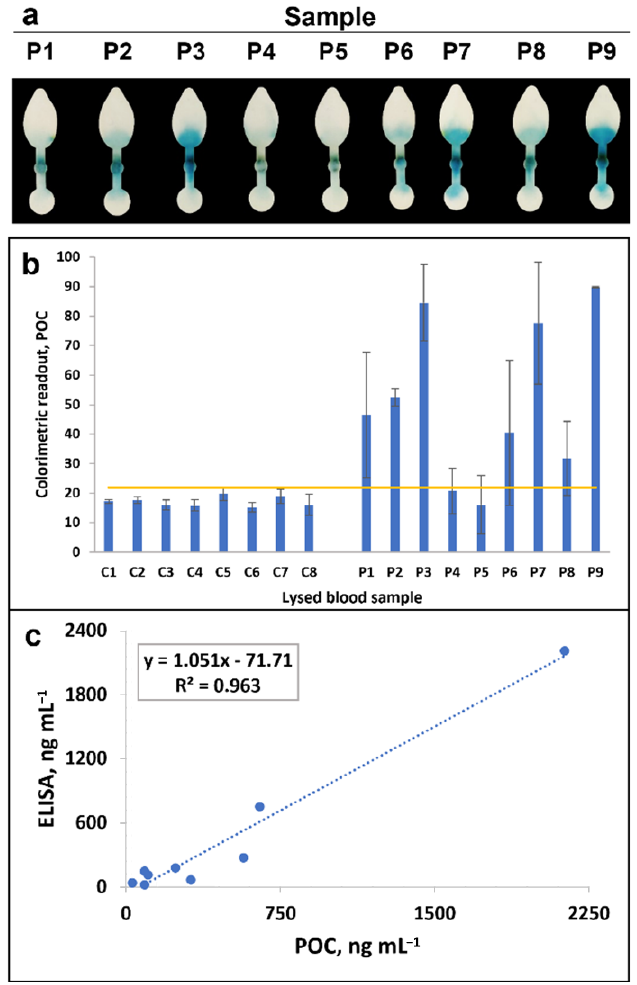
Figure 5. Detection of clinical whole blood samples using the µPAD. ( a ) Images of the colour readouts obtained in the µPAD for 9 blood samples obtained from patients infected with P. falciparum (lysed and diluted 1:10 with PBST-BSA). ( b ) Colorimetric readout obtained in samples negative (C1-8) or positive (P1-9) for P. falciparum (the horizontal line in the graph represents the analytical LOD, calculated from the signals and SD registered for the negative clinical samples). ( c ) Correlation of the concentration of Pf-LDH detected by the smartphone-based µPAD and the reference ELISA (samples diluted 1:10, except for sample P7, which was diluted to 1:100 due to signal saturation in the 1:10